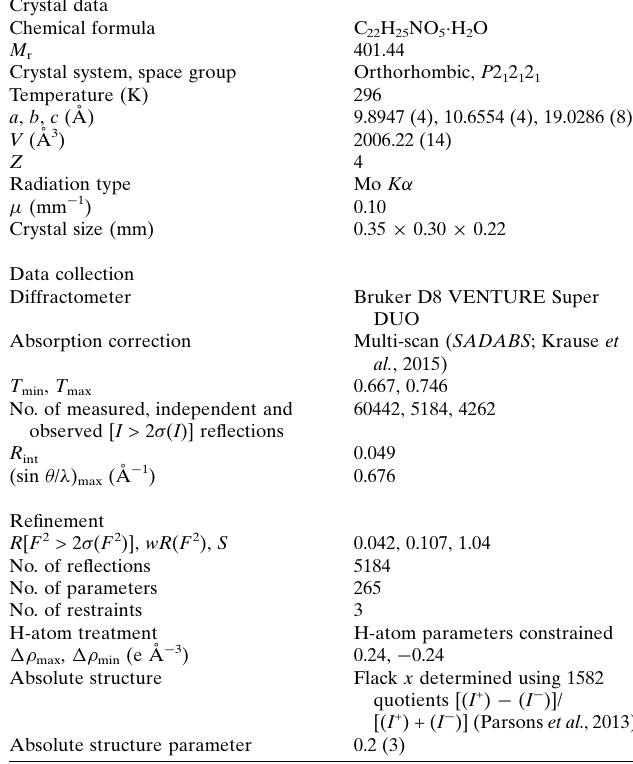
Table 2 Experimental details. Crystal data Chemical formula